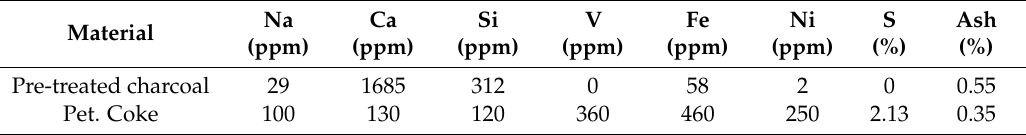
Table 2. Inorganic concentrations and ash content of pre-treated charcoal and industrial petroleum